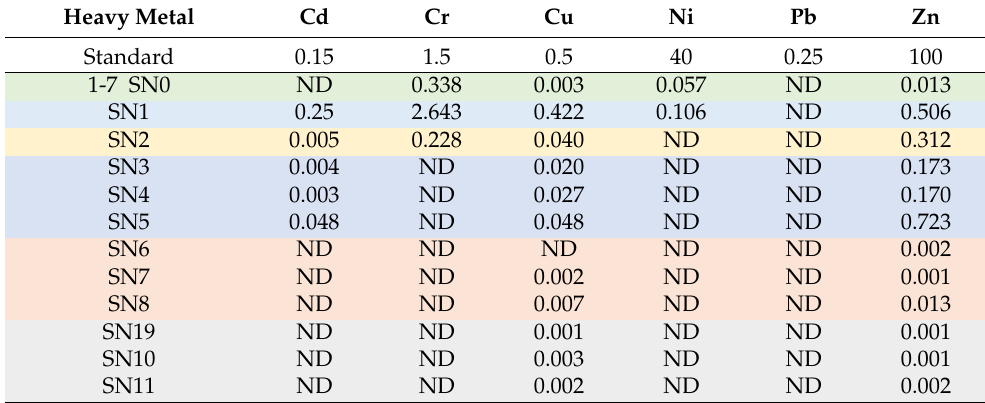
Table 4. Leaching concentration of heavy metals in cement mortars